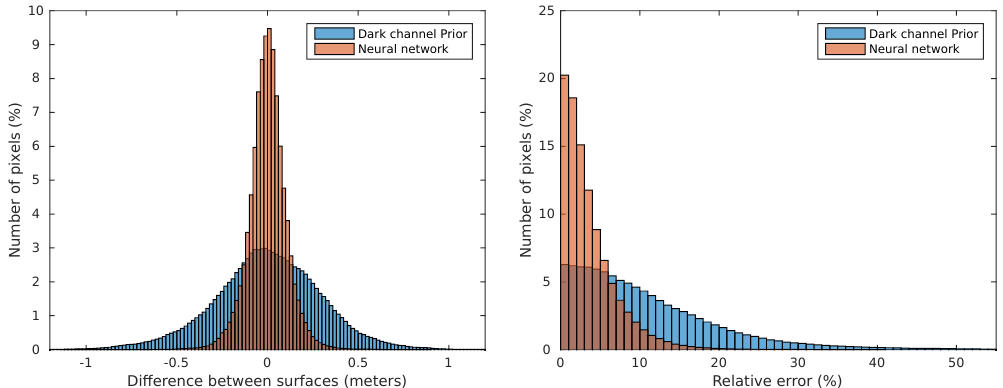
Figure 5. Error histograms, ARMSE ( left ) RARMSE ( right ), for all the images pixels comparing neural network and dark channel